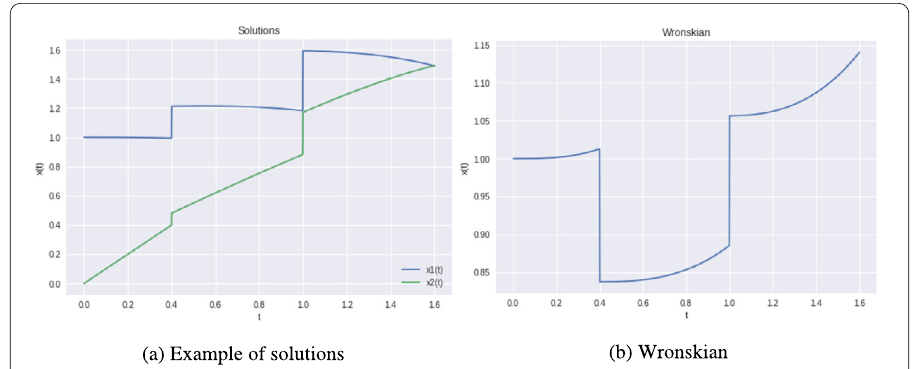
Figure 3 Calculating the Wronskian of the fundamental system of solutions of a homogeneous equation